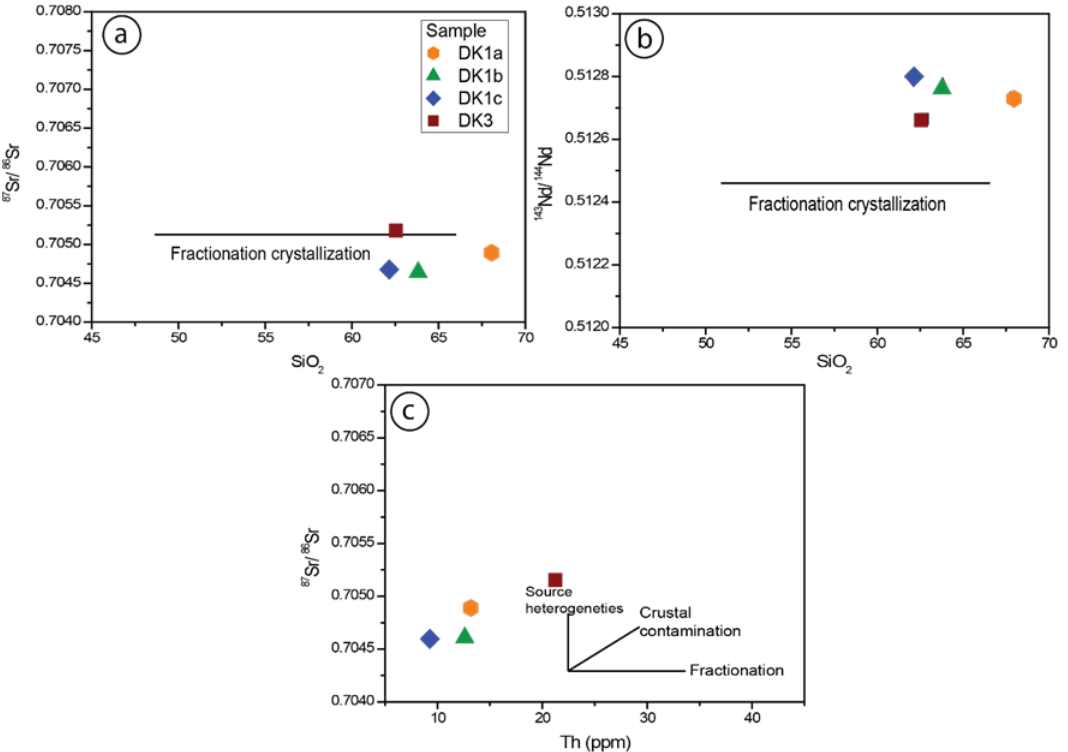
Figure 16. Variation diagrams. ( a ) 87 Sr/ 86 Sr versus SiO 2 ; ( b ) 143 Nd/ 144 Nd vs. SiO 2 ; and ( c ) 87 Sr/ 86 Sr versus Th [62].